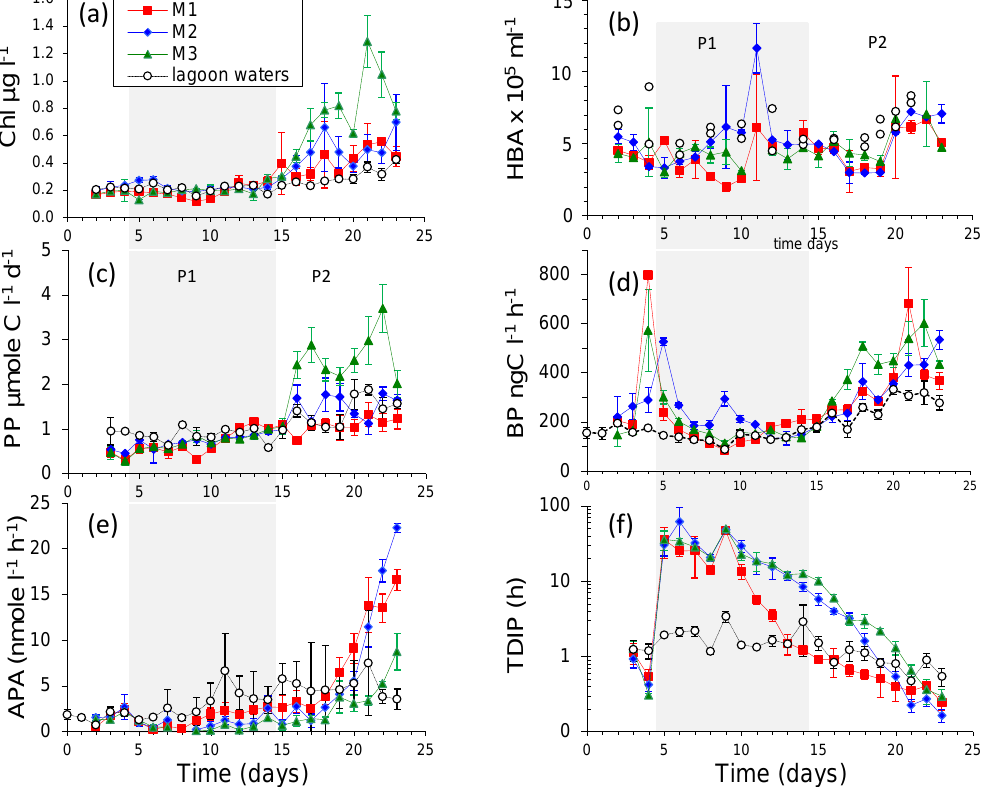
Figure 3. Evolution of (a) chlorophyll a (Chl), (b) heterotrophic bacterial abundance (HBA), (c) primary production (PP), (d) heterotrophic bacterial production (BP), (e) alkaline phosphatase activity (APA) and (f) DIP turnover time (TDIP) in the three mesocosms M1, M2, M3 and in the lagoon waters (lagoon). Each point is the mean of the three depths sampled, error bars are standard deviations. For lagoon HBA, only data from 1 and 12m depth are available occasionally and discrete data are presented